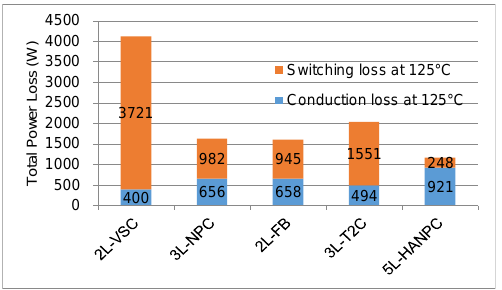
Figure 2. Power loss comparison under ±400 V DC in the inverter mode (power factor: 0.76, M = 0.94, f s = 15 kHz, and I ac = 100 A).